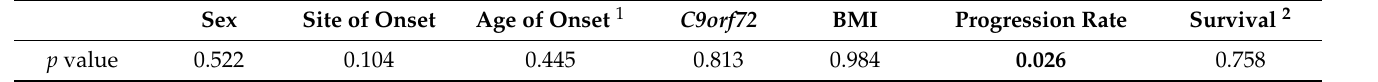
Table 6. Associations of CSF BDNF levels with ALS clinical variables.